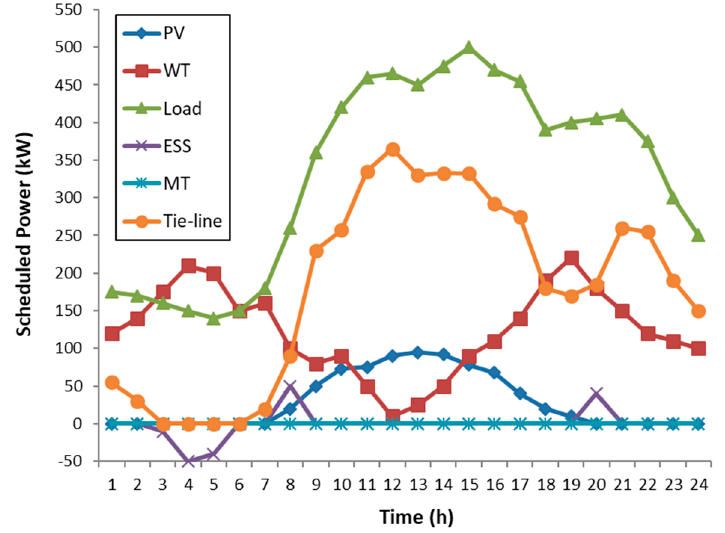
Figure 8. Scheduled power scheme for distributed units for Case 1.